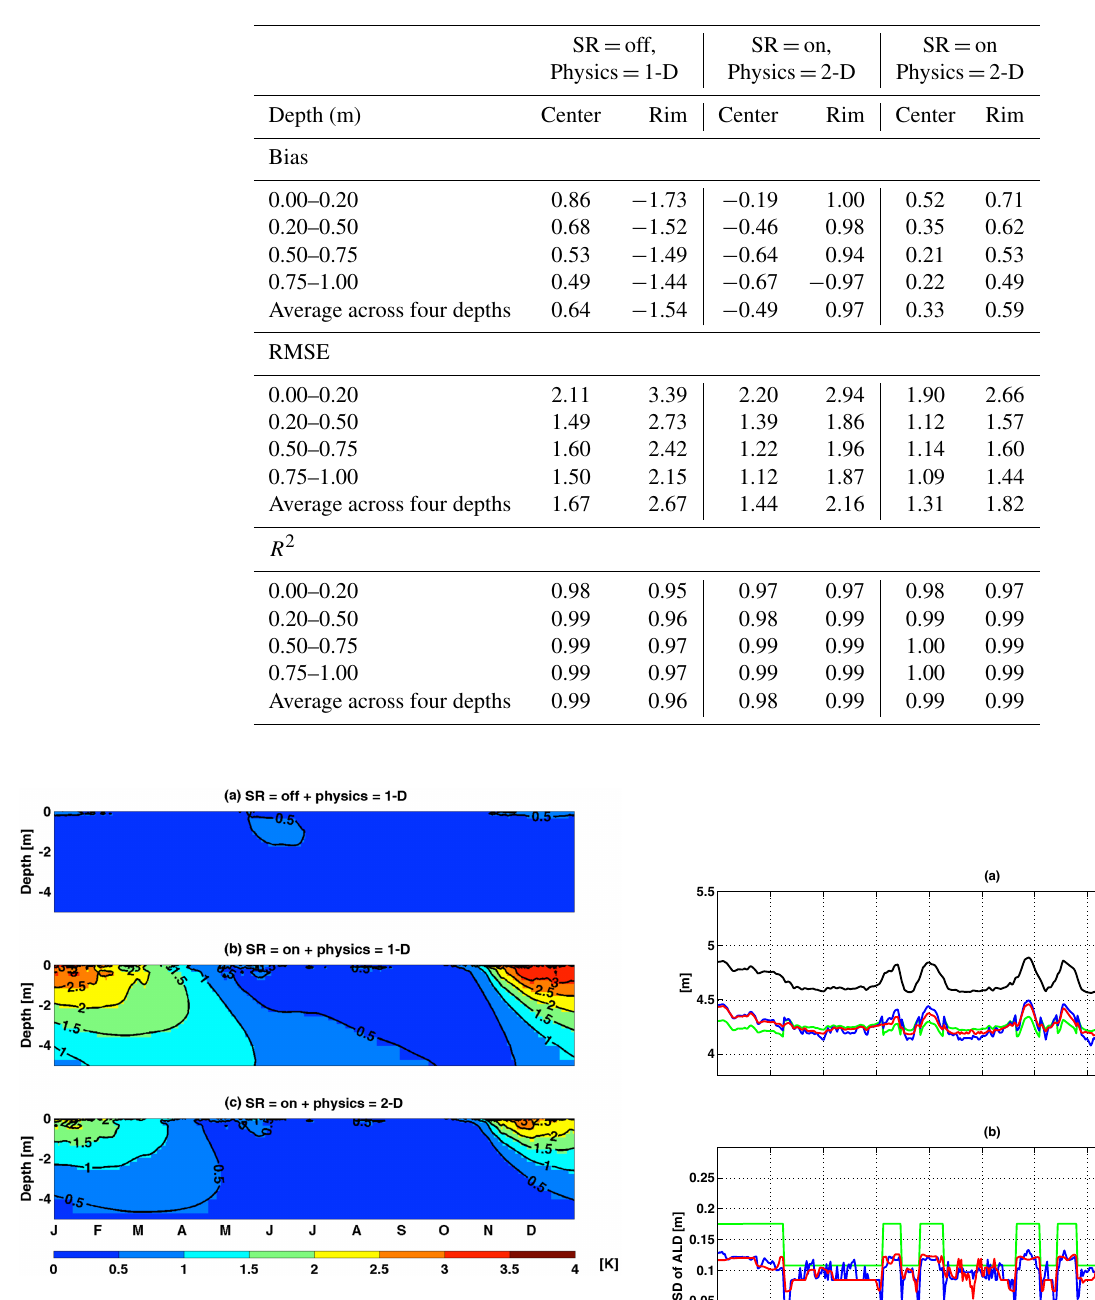
Table 2. Bias, root mean square error (RMSE), and correlation ( R 2 ) between modeled and observed soil temperature at polygon center and rim at multiple soil depth for 2013 for three cases: snow redistribution (SR) off and 1-D physics, SR on and 1-D physics, and SR on and 2-D physics.